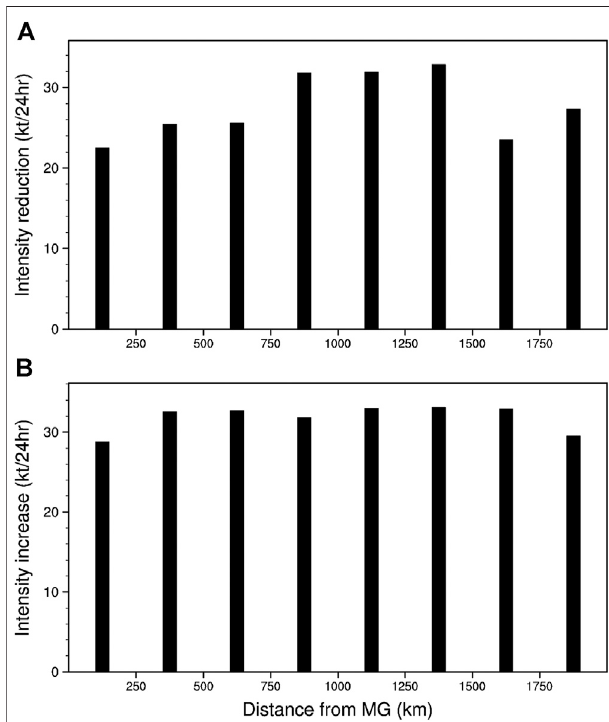
FIGURE 8 | The azimuthally averaged intensity changes of RW events (A) andthatofRIevents (B) asafunctionofthedistanceoftheTCcenterfrom the MG center. The vertical coordinate indicates the 24-h TC intensity changes (knot).